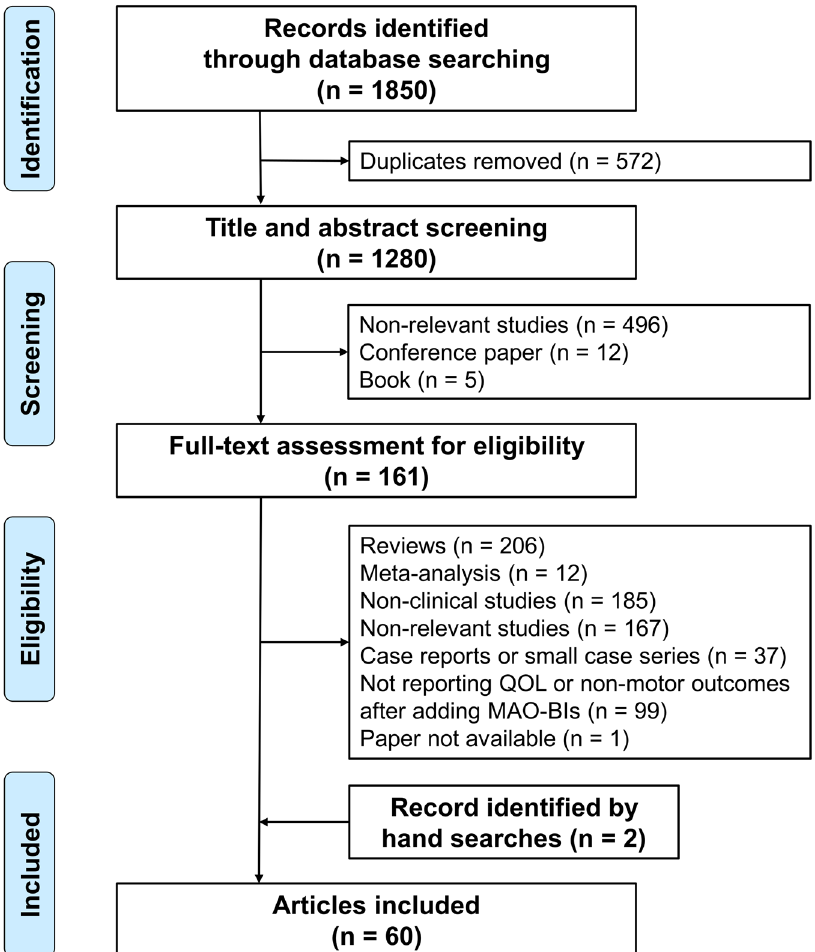
Fig. 1 Flowchart of the literature search. A systematic literature search using the PubMed, Scopus, and Cochrane Library databases was